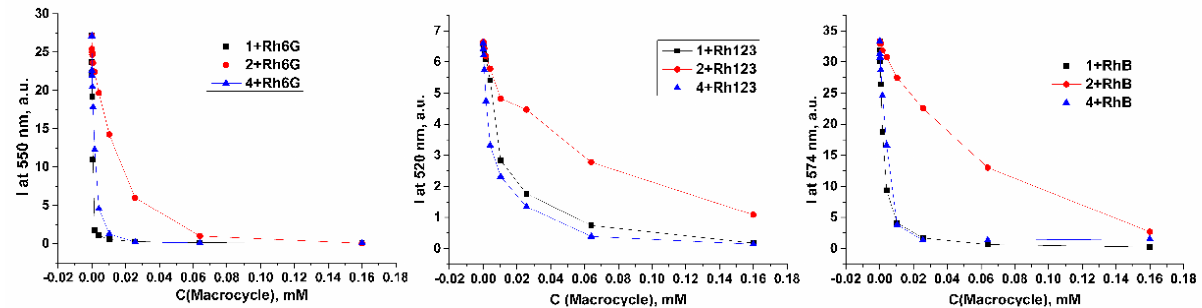
Figure 2. Fluorescent titration of Rh6G, Rh123 and RhB (1 μ M) with macrocycles 1 , 2 and 4 in PBS buffer (pH 7.4) at 37 °C.